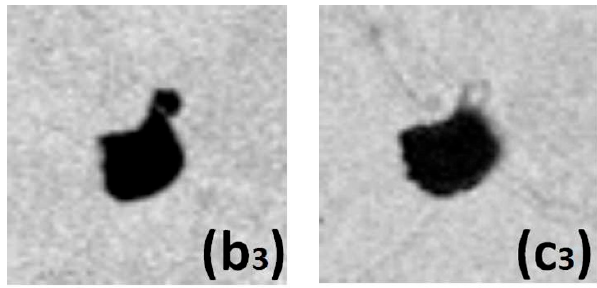
Figure 5. Graphs are local enlarged diagrams ( b 3 ) 15 s; and ( c 3 ) 35 s.